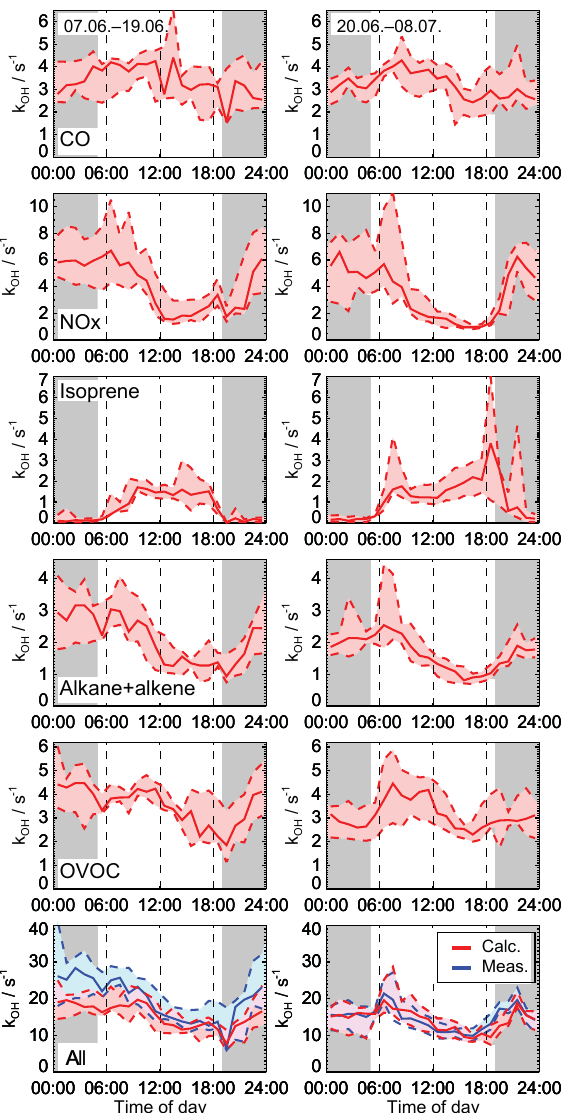
Figure 5. Median diurnal profiles of reactivity from major measured OH reactants and of the total measured and calculated OH reactivity for the first and second part of the campaign. Data are only included if all major OH reactants and OH reactivity were measured concur- rently. Colored areas give 25 and 75 percentiles. Gray areas indicate nighttime.